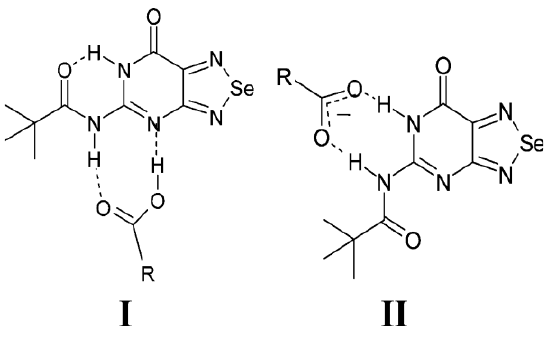
Scheme 10.: Mode of binding of 36 to (I) a carboxylic acid